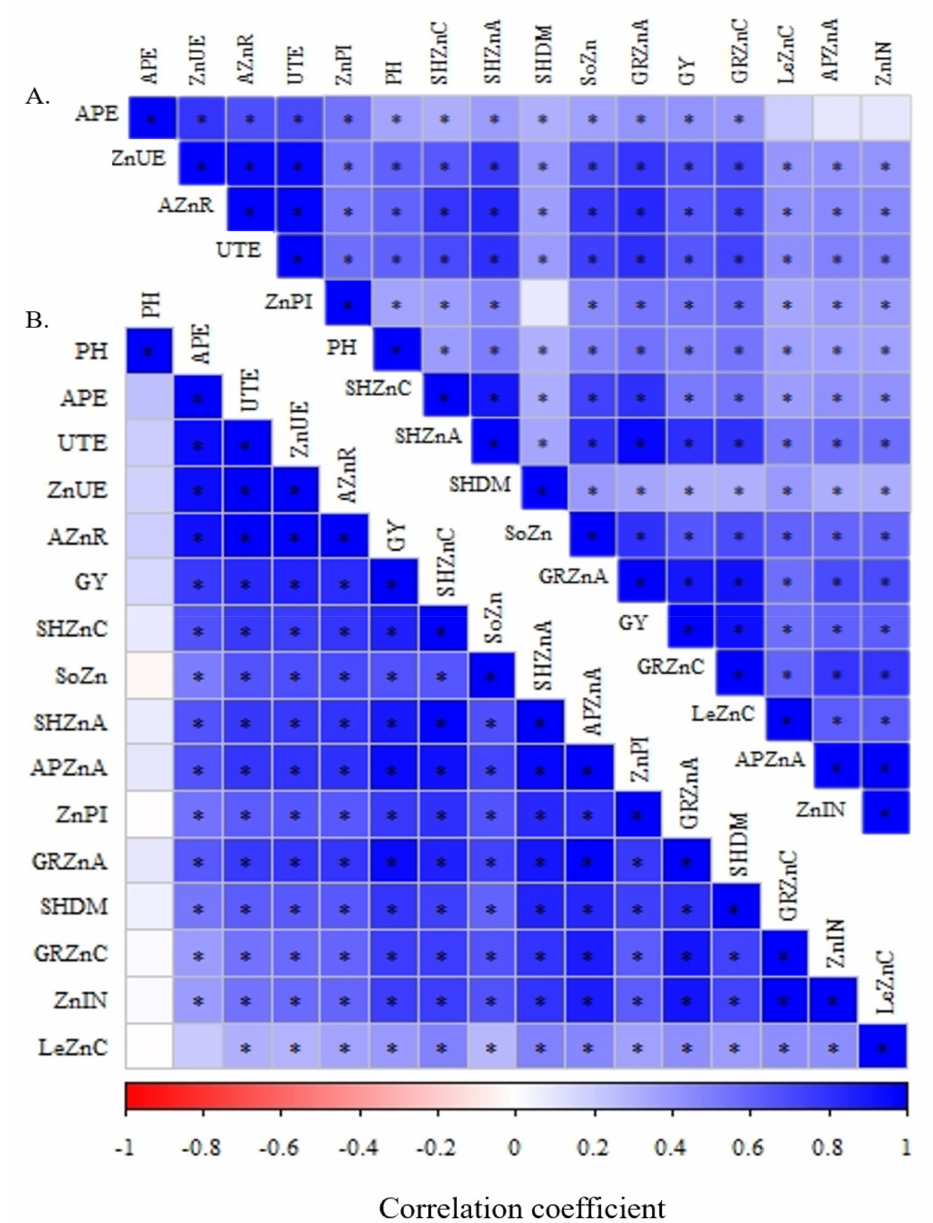
Figure 5. Heatmap showing Pearson’s correlation among the analyzed parameters from soil and common bean plants in response to different soil Zn applications and diazotrophic bacteria inoc- ulations in the 2019 ( A ) and 2020 ( B ) crop seasons. * indicates a significant relationship ( p ≤ 0.05). Abbreviations: SoZn = Zn content in soil, LeZnC = Zn concentration in leaf tissue, SHZnC = Zn concentration in shoot, SHZnA = Zn accumulated in shoot, APZnA = Zn accumulated in aerial part (shoot + grain), GRZnC = Zn concentration in grain, GRZnA = Zn accumulated in grain, SHDM = shoot dry matter, GY = grain yield, PH = plant height, ZnPI = Zn partioning index, ZnIN = Zn intake, ZnUE = Zn use efficiency, APE = Agro-physiological efficiency, AZnR = Applied Zn recovery, and UTE = Utilization